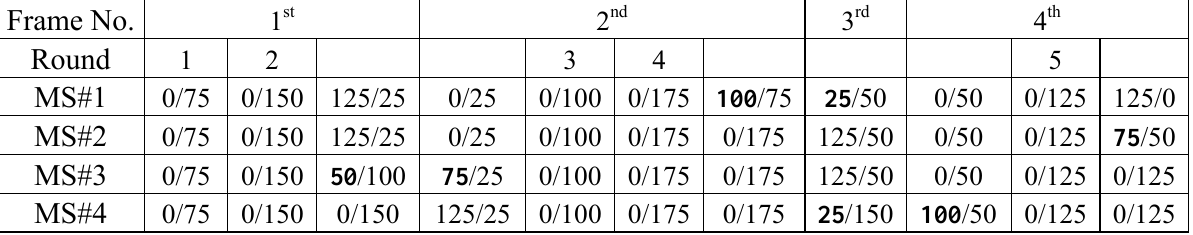
Table 2. Updated Deficit Counter for DRRF (Transmitted Packet Size/Deficit Counter) [10]. Frame